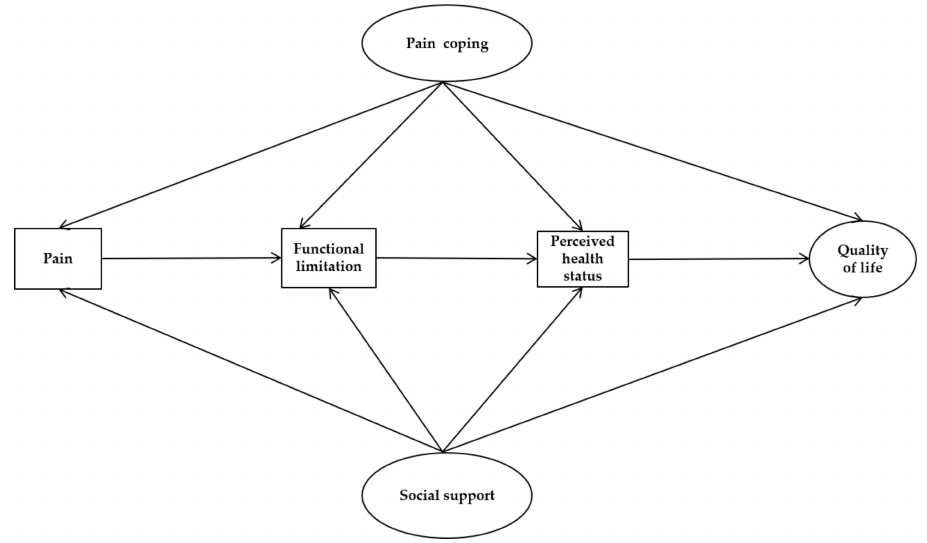
Figure 1. Hypothetical model of the